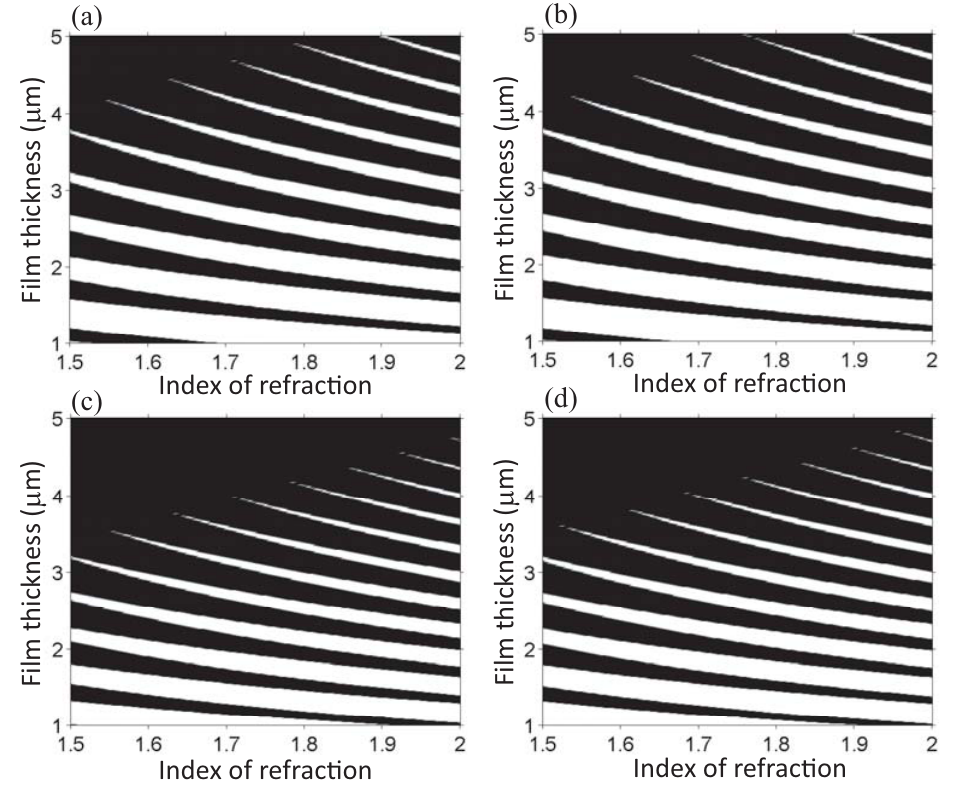
Figure 8. Existence maps of reflection minima in the angle of incidence range 30–60° as a function of unpoled index and film thickness using 20 nm thick gold as the transparent electrode: ( a ) 1,550 nm with s -polarized light; ( b ) 1,550 nm with p -polarized light; ( c ) 1,320 nm with s -polarized light; and ( d ) 1,320 nm with p -polarized light. Black regions indicate the existence of at least one reflection minimum whereas white regions indicate the absence of reflection